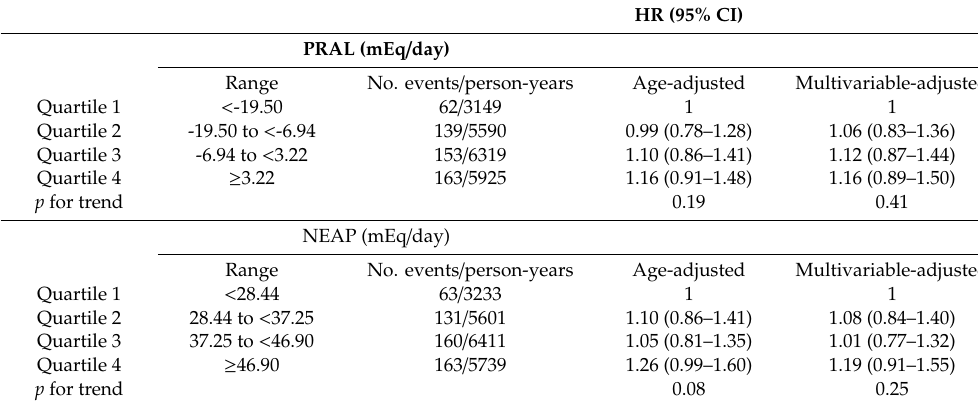
Table 1. Dietary acid load and risk of breast cancer recurrence in entire WHEL